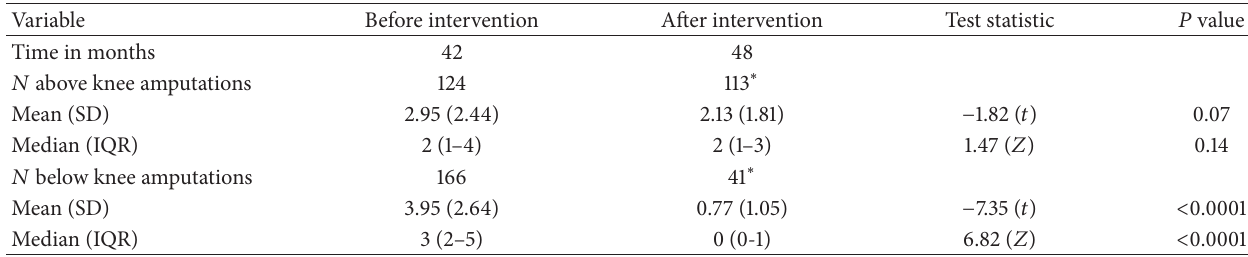
Table 2: Major amputations by type at Georgetown Public Hospital